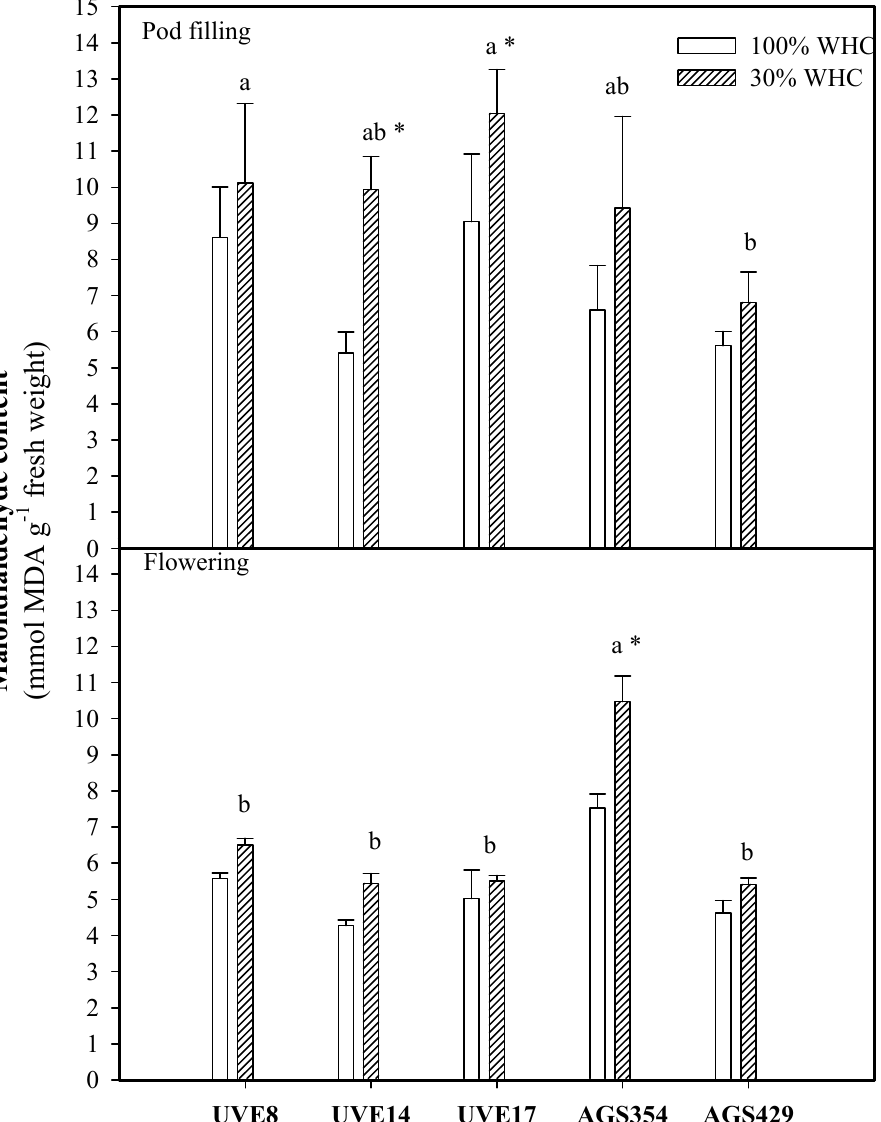
Figure 3. Malondialdehyde (MDA) content for five vegetable-type soybean cultivars subjected to two water treatments at flowering and pod-filling stages. Values represent means ± SD ( n = 3). Letters represent significant differences/similarities in MDA content for various cultivars under severe water stress at 30% water holding capacity (WHC), * represents significance at p ≤ 0.05.